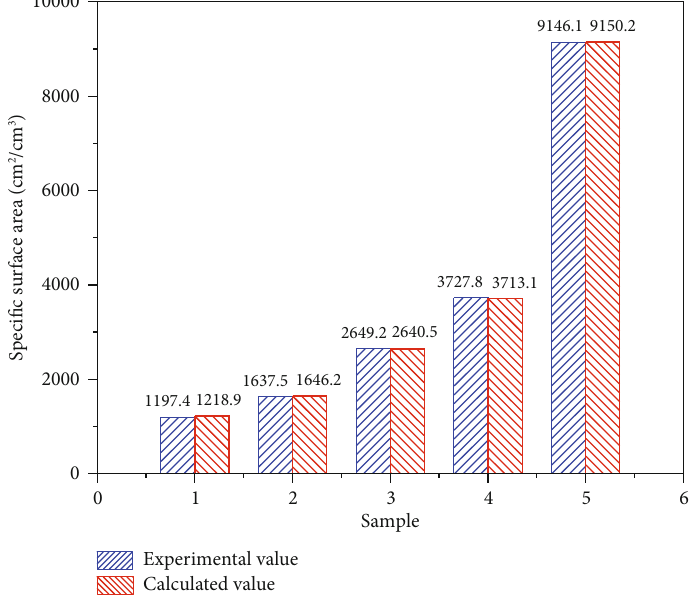
Figure 8: Comparison of experimental and calculated values of foamed nickel speci fi c surface